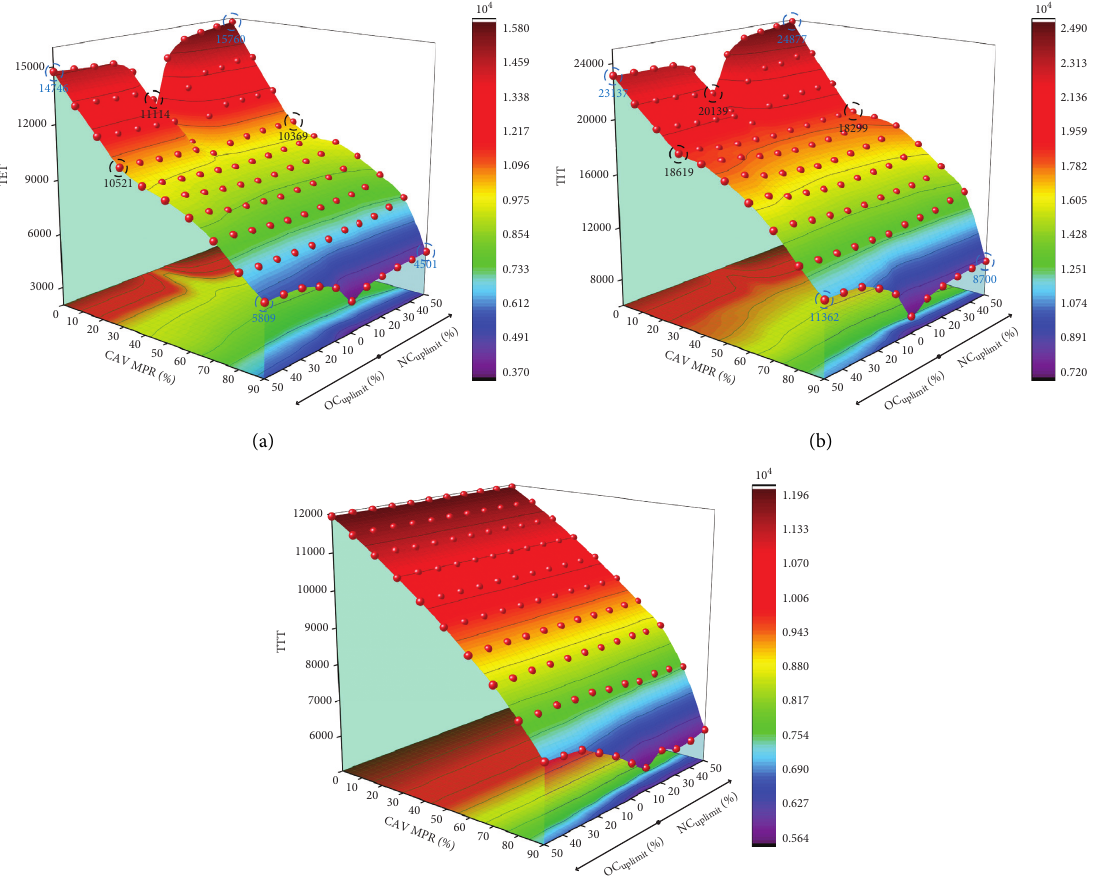
Figure 6: Impact of driver heterogeneity on safety and efficiency. (a) TET. (b) TIT. (c)